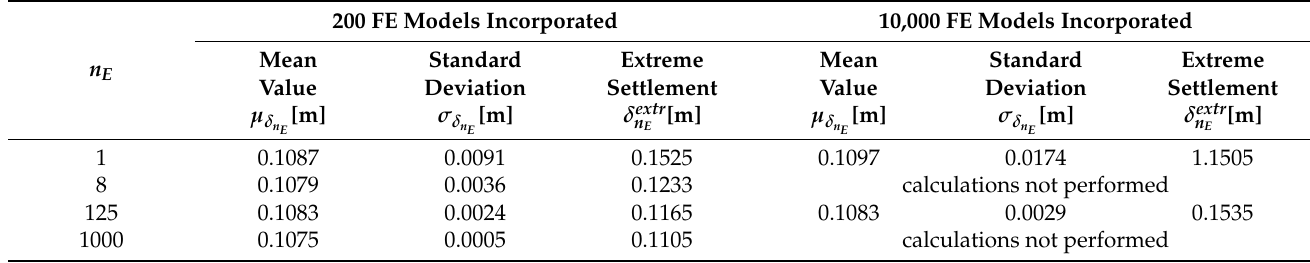
Table 2. Soil block settlement parameters, the 200-item and the 10,000-item simulation procedure, and the Monte Carlo FE material model.